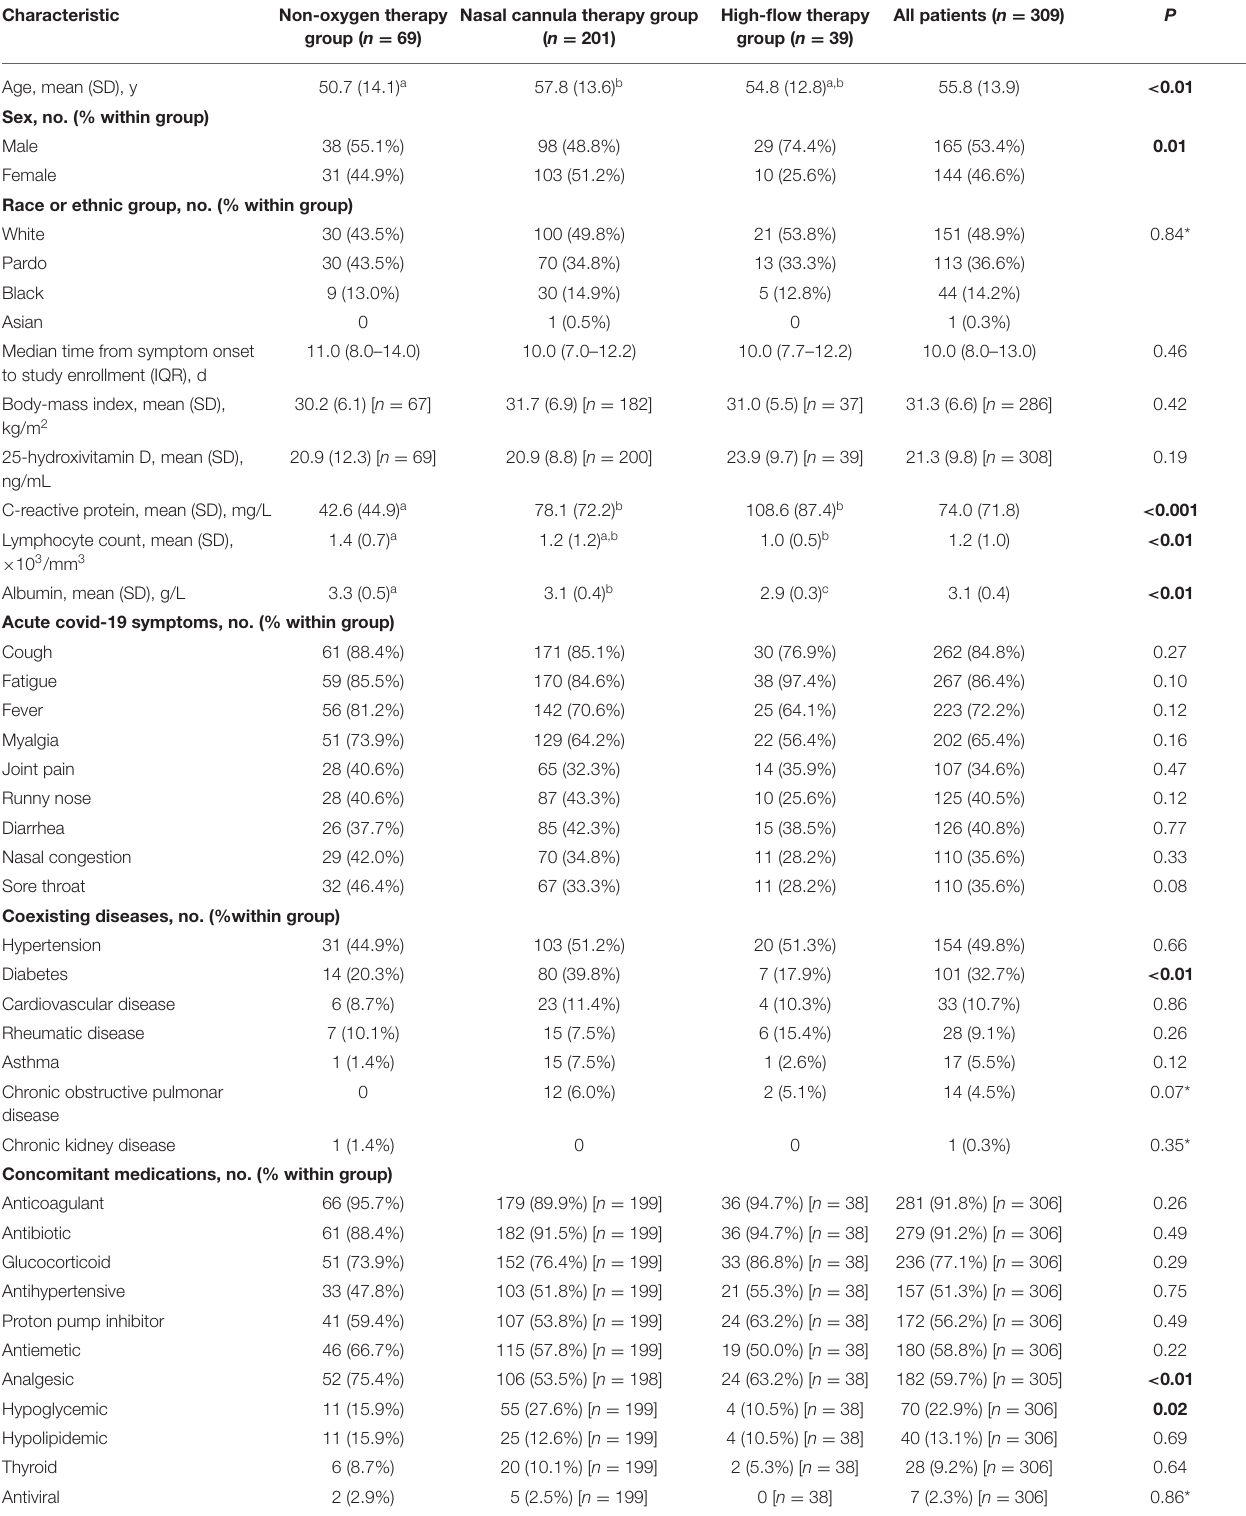
TABLE 1 | Demographic and clinical characteristics according to oxygen therapy requirement at admission.